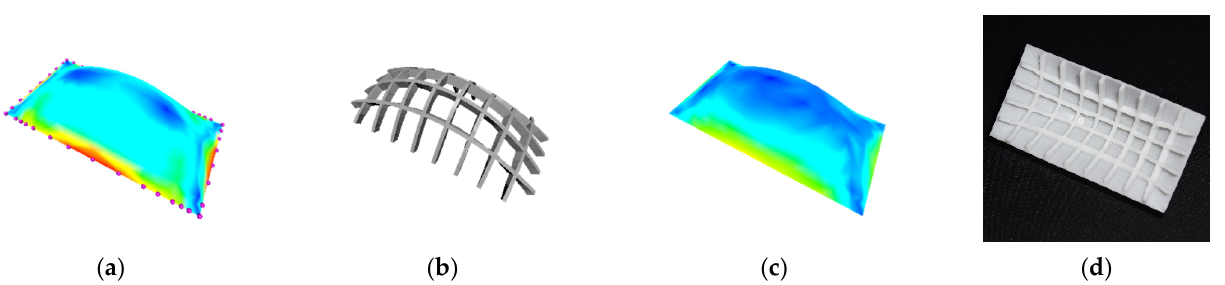
Figure 14. Bidirectionally stiffened dome, from left to right: ( a ) initial stress without stiffeners; ( b ) optimized stiffeners; ( c ) final stress with stiffeners; ( d ) 3D print.